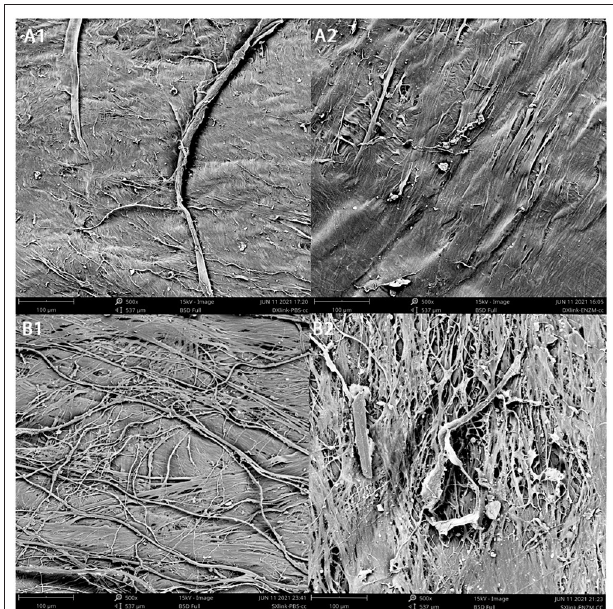
FIGURE 6 | Surface appearance of concave side of the samples under SEM following degradation. (A1) , crosslinked dura mater in PBS; (A2) , crosslinked dura mater in enzyme solution; (B1) , crosslinked sclera in PBS; (B2) , crosslinked sclera in enzyme solution.